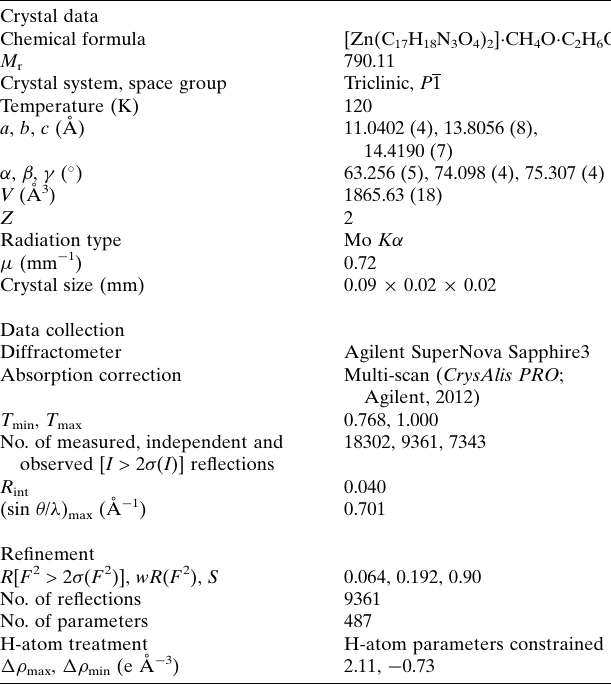
Table 2 Experimental details. Crystal data Chemical